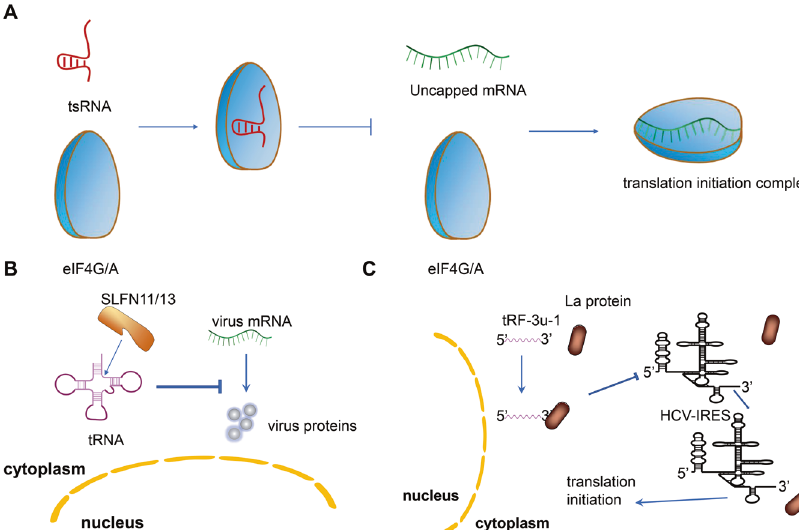
Fig. 3 The function of tsRNA on protein translation inhibition. A tsRNA binds to eIF4G/A complex displaces mRNA without cap structure to cause translational inhibition. B SLFN11/13 inhibits virus proteins synthesis by cleaving tRNA. C tRF-3U-1 inhibits HCV IRES-mediated translation by isolating limited La/SSB in the